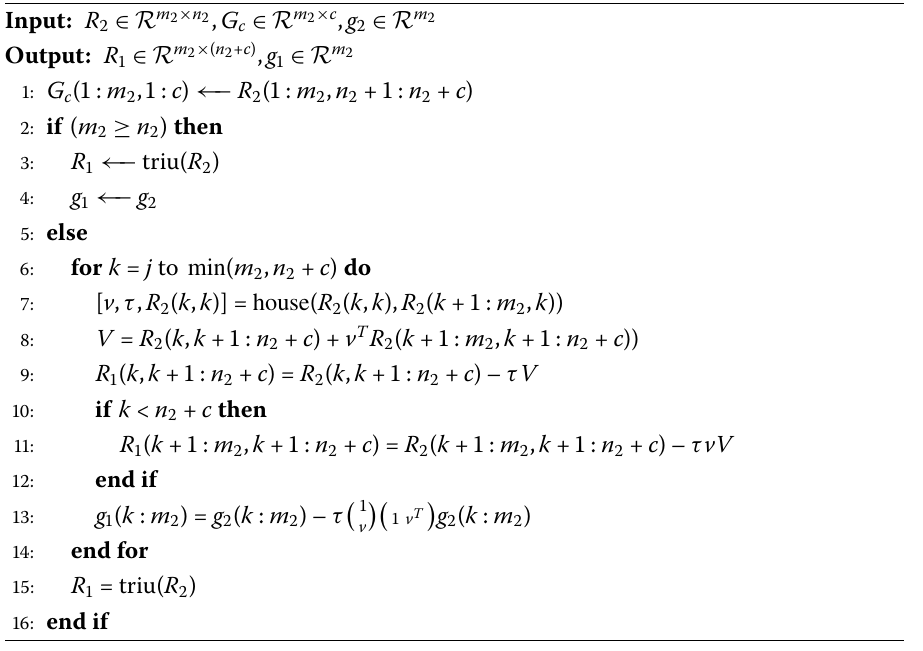
Algorithm  Updating R  factor after appending a block of columns G